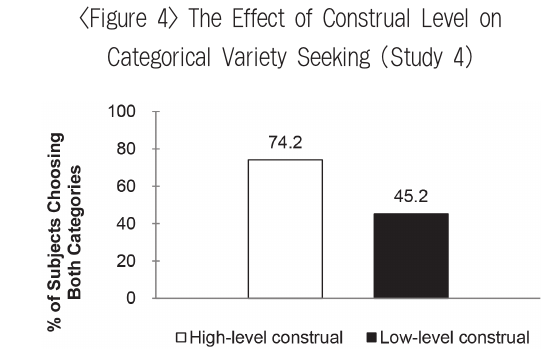
<Figure 4> The Effect of Construal Level on Categorical Variety Seeking (Study